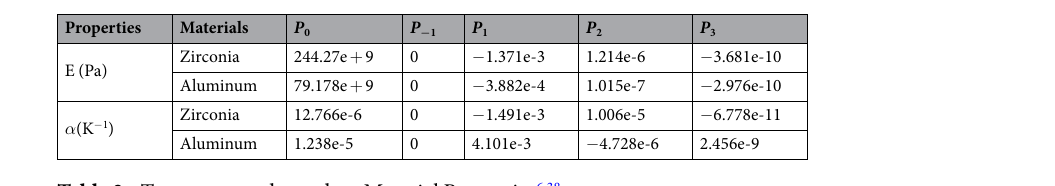
Table 2. Temperature-dependent Material Properties 6,38